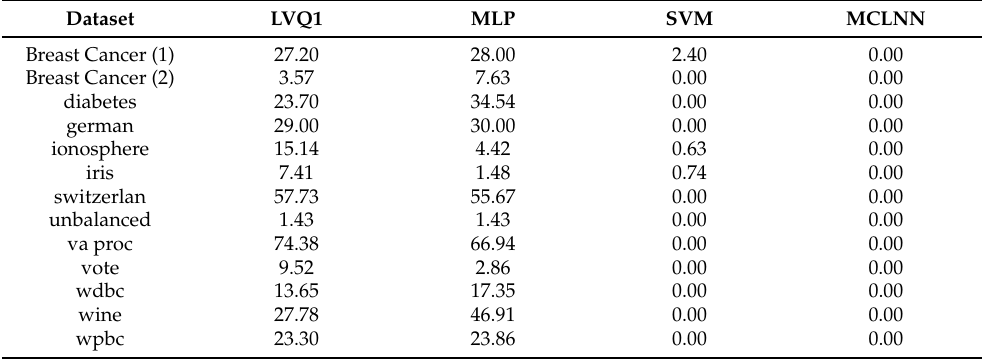
Table 7. Comparison of the best error rates given by different techniques and the proposed neural architecture applied to the training dataset (learning phase).